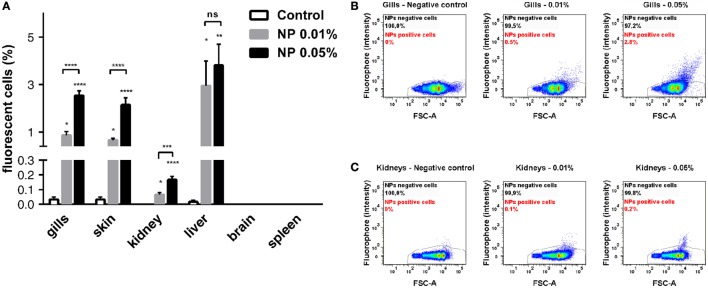
Quantitative analysis of poly(lactic acid) nanoparticles (PLA-NPs) uptake in primary and secondary exposure organs. (A) Flow cytometry analysis of nanoparticle (NP) uptake in gills, skin, kidney, liver, brain, and spleen, following exposure to 0.01 or 0.05% red fluorescent NPs. Histograms represent the mean percentage of positive cells for each organ. While no NP uptake was detected in brain and spleen, PLA-NPs significantly penetrated all other organs in a dose-dependent manner, except for the liver where no significative fluctuation was observed. (B,C) Representative biparametric representations of NP uptake in gills (B) and whole-kidney marrow (C). NP-positive cells are mainly found among FSC-high cells. Error bars: SEM. Significance level is indicated as: *p < 0.05, **p < 0.01, ***p < 0.001, ****p < 0.0001. Number of fish per condition (control/0.01/0.05%): gills (9/13/9), skin (9/13/9), kidneys (12/12/12), liver (12/12/12), brain (6/6/6), and spleen (6/6/6).